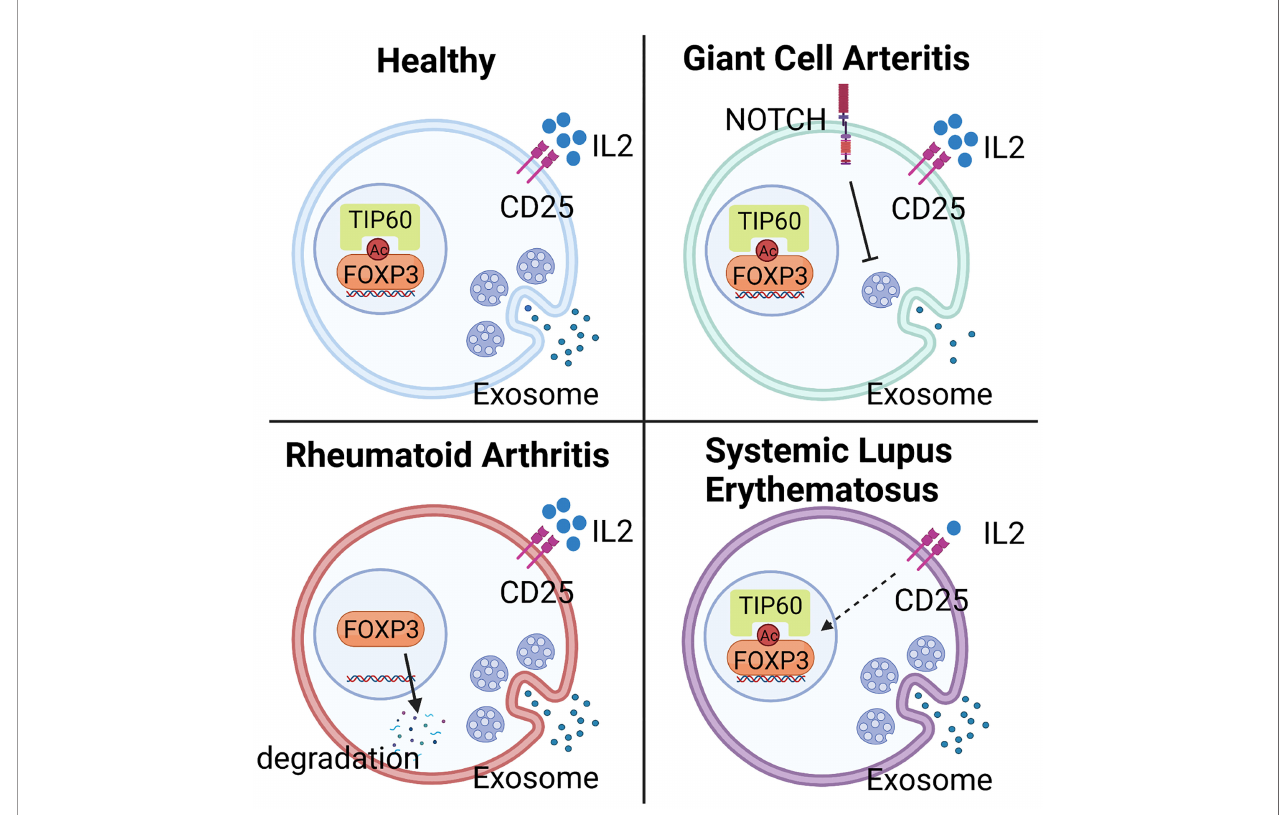
FIGURE 3 | Mechanisms underlying Treg de fi ciency in different autoimmune diseases. Abnormalities in Treg frequency and function are observed in most autoimmune diseases, including Giant Cell Arteritis (GCA), Rheumatoid Arthritis (RA), and Systemic Lupus Erythematosus (SLE), but molecular mechanisms underlying the de fi ciency are disease speci fi c. In GCA, hyperactivity of NOTCH4 signaling in CD8 + Treg cells reroutes the intracellular vesicle traf fi cking and blocks the production of NOX2-containing exosome, leading to impaired immunosuppressive function. In RA, low expression of the histone acetyltransferase TIP60 in Treg cells causes abnormal post-translational modi fi cation and instability of FOXP3, impairing Treg cell differentiation and immunosuppressive ability. In SLE, de fi ciency of Treg cells mainly results from the low availability of IL-2, a consequence of defective IL-2 expression by surrounding cells, such as effector T